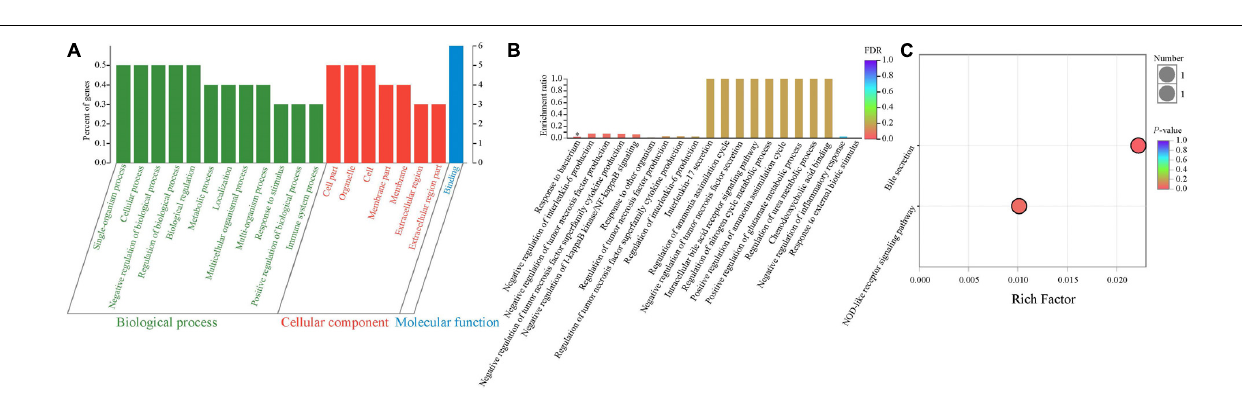
FIGURE 3 | Functional enrichment analysis of differentially expressed genes between NBW and IUGR piglets. (A) Gene Ontology categories enriched for differentially expressed genes. The abscissa represents the secondary classification terms of GO, the left ordinate represents the percent of genes enriched in the secondary classification, and the right ordinate represents the number of genes. These three colors represent three categories: green represents the biological process, red represents the cellular component, and blue represents the molecular function. (B) Gene Ontology enrichment analysis enriched for differentially expressed genes. Significantly enriched GO terms were selected based on a FDR < 0.05. (C) KEGG pathway enrichment analysis of differentially expressed